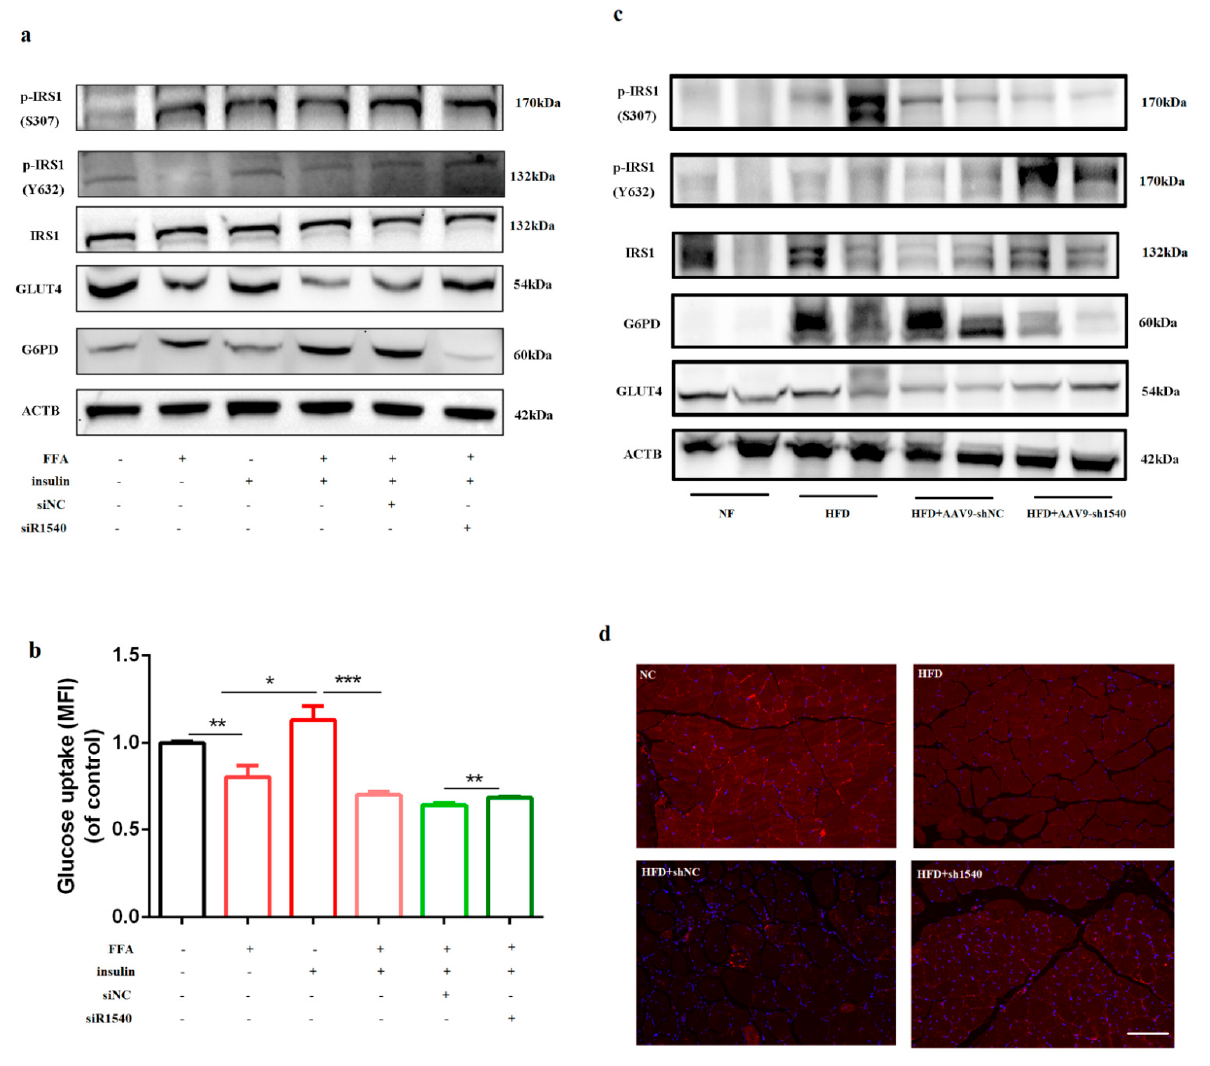
Figure 6. Knock − down of G6PD rescued the impaired insulin signaling in an insulin-resistant model. ( a ) Western blot analysis for G6PD, GLUT4 and insulin signaling protein after co-treatment with FFA, insulin and G6PD siRNA. ( b ) Flow cytometry assay for glucose uptake detection after co-treatment with FFA, insulin and G6PD siRNA. * p < 0.05, ** p < 0.01, *** p < 0.001. ( c ) Western blot analysis for G6PD, GLUT4 and insulin signaling protein after AAV9-sh1540 injec- tion in HFD mice. ( d ) GLUT4 membrane translocation after AAV9-sh1540 injected HFD mice; scale bar = 100 μ m.